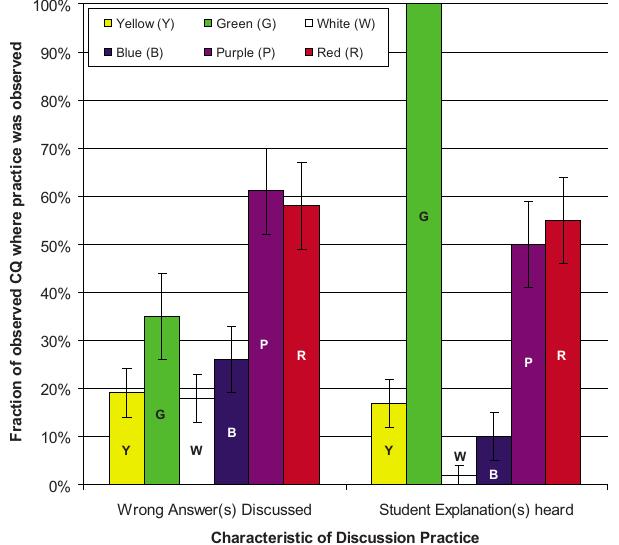
FIG. 4. (cid:1) Color (cid:2) The percentage of observed CQs where the wrong answers were discussed and student explanations were heard. The error bars shown are the standard error on the proportion.